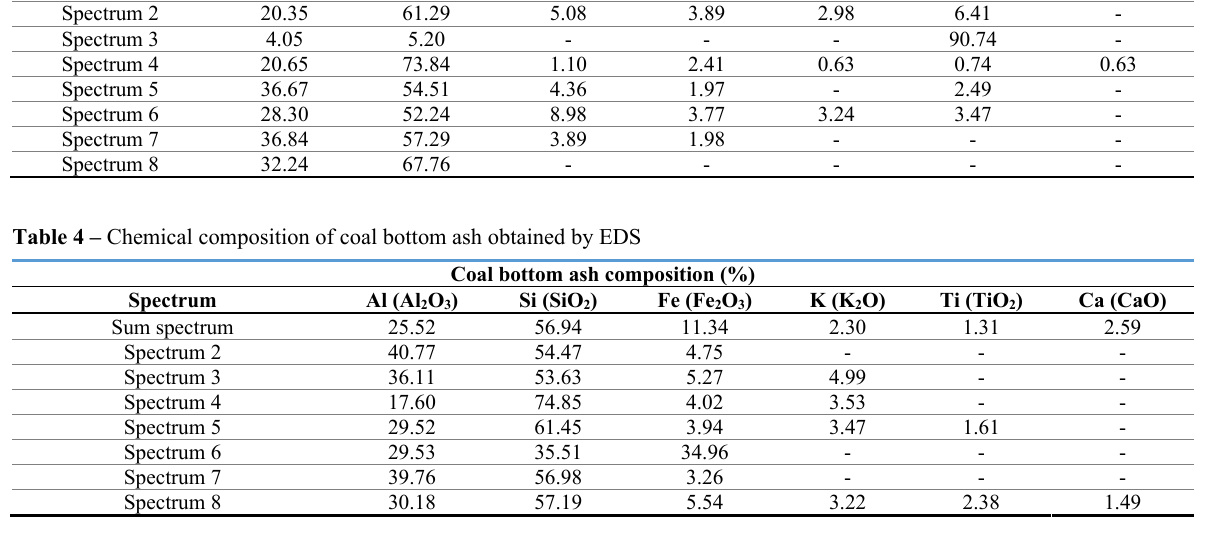
Fly ash chemical composition (%)